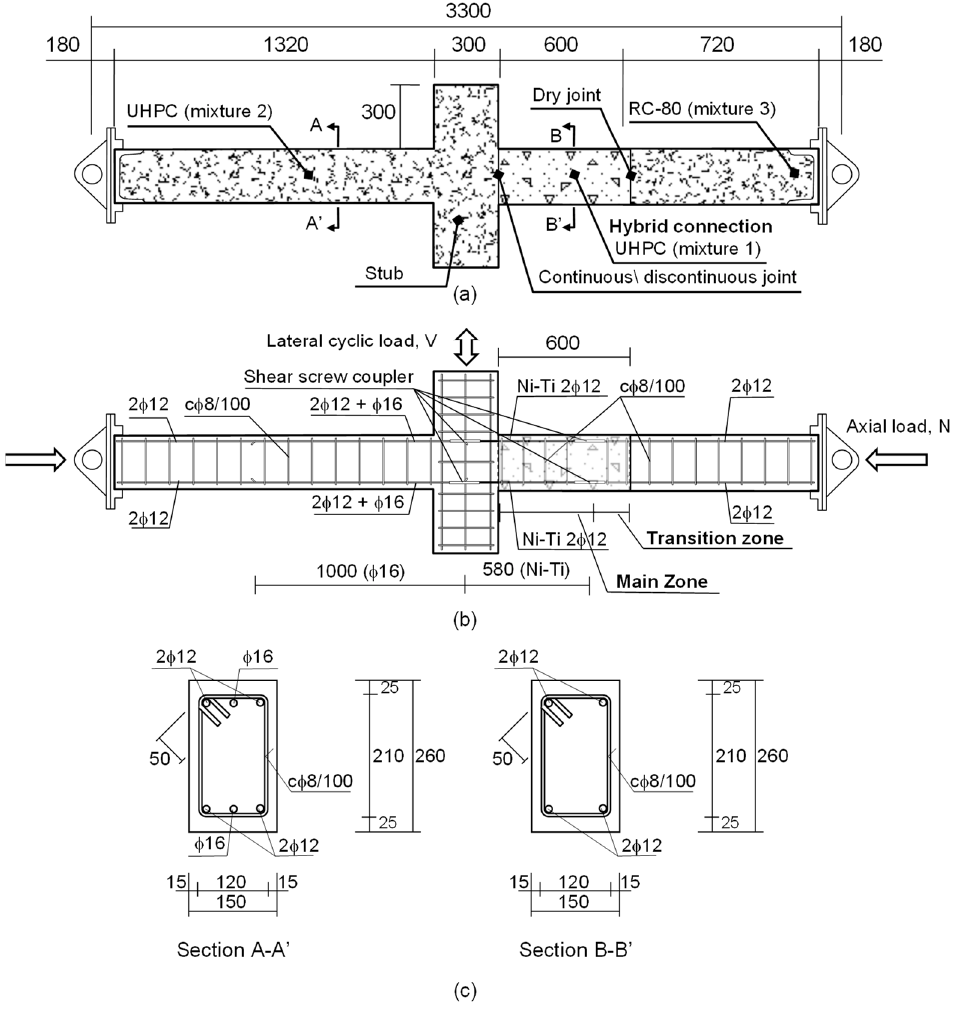
Figure 1. Specimen 1–4 details: ( a ) dimensions (unit: mm), ( b ) longitudinal reinforcement, and ( c ) cross-section details.